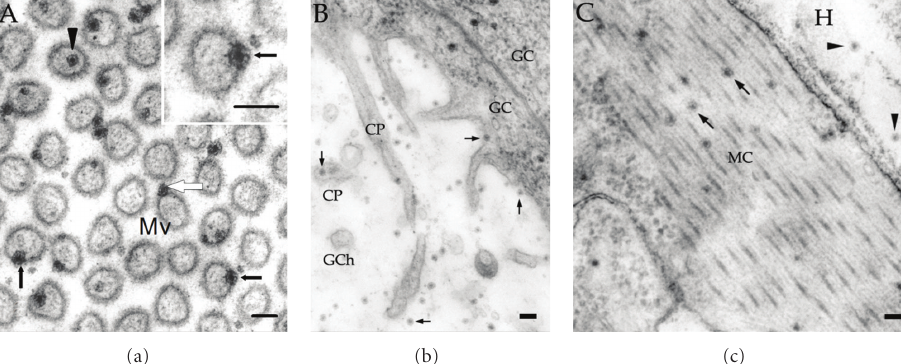
Figure 1: Electron micrographs of Bombyx mori midgut cells perorally inoculated with BmCPV-1. (a) Cross-section of microvilli (Mv) showing di ff erent stages of virus entry into midgut columnar cells. Intact virions were seen to adhere to (open arrow), penetrate (filled arrows), and be inside (arrowhead) the microvilli. Insert: higher magnification of a virion penetrating the membrane. (b) Virions (arrows) were detected in the goblet chamber (GCh) and in the cytoplasmic projections (CP) and the cytoplasm of the goblet cell (GC). (c) Virions (arrows) were distributed among myofibrils in the cytoplasm of midgut muscle cell (MC). Several virions (arrowheads) occurred in the haemocoel (H). Bars = 100 nm